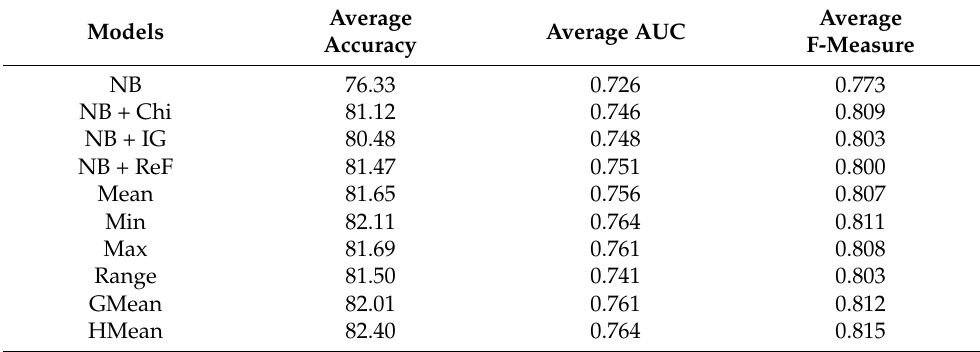
Table 4. Comparison of NB models with proposed RMFFS methods, IG, CS, REF and No FS method.